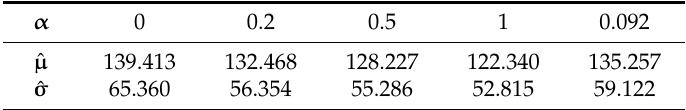
Table 3. MDPDE for the Gumbel distribution according to α